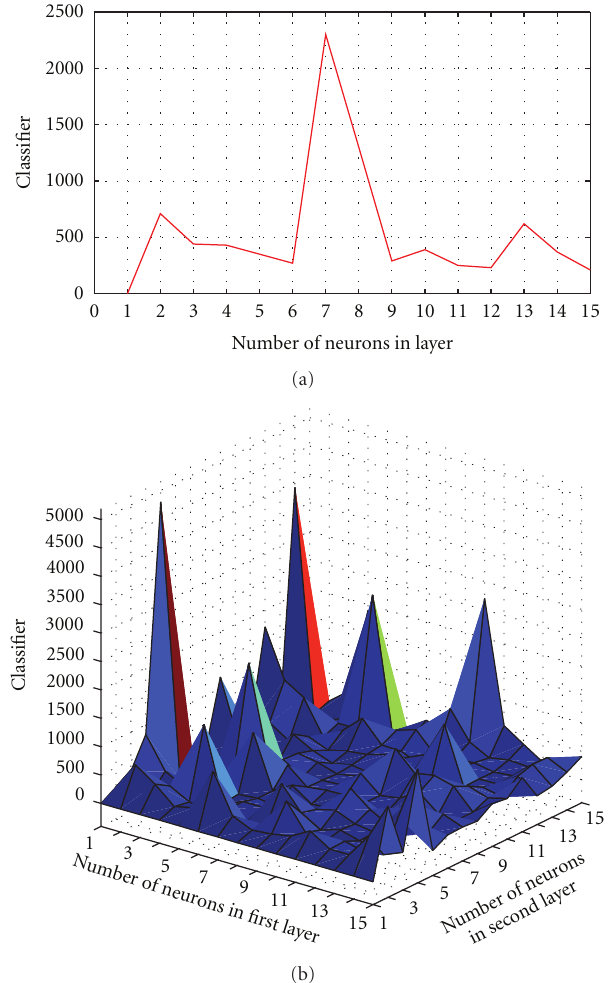
Figure 11: Neural-wavelet damage metric ( Γ NW ) and descriptive damage metric ( Γ ASCE ) for all ASCE benchmark structure config- urations reported in Phase II-E (Configuration 5 is